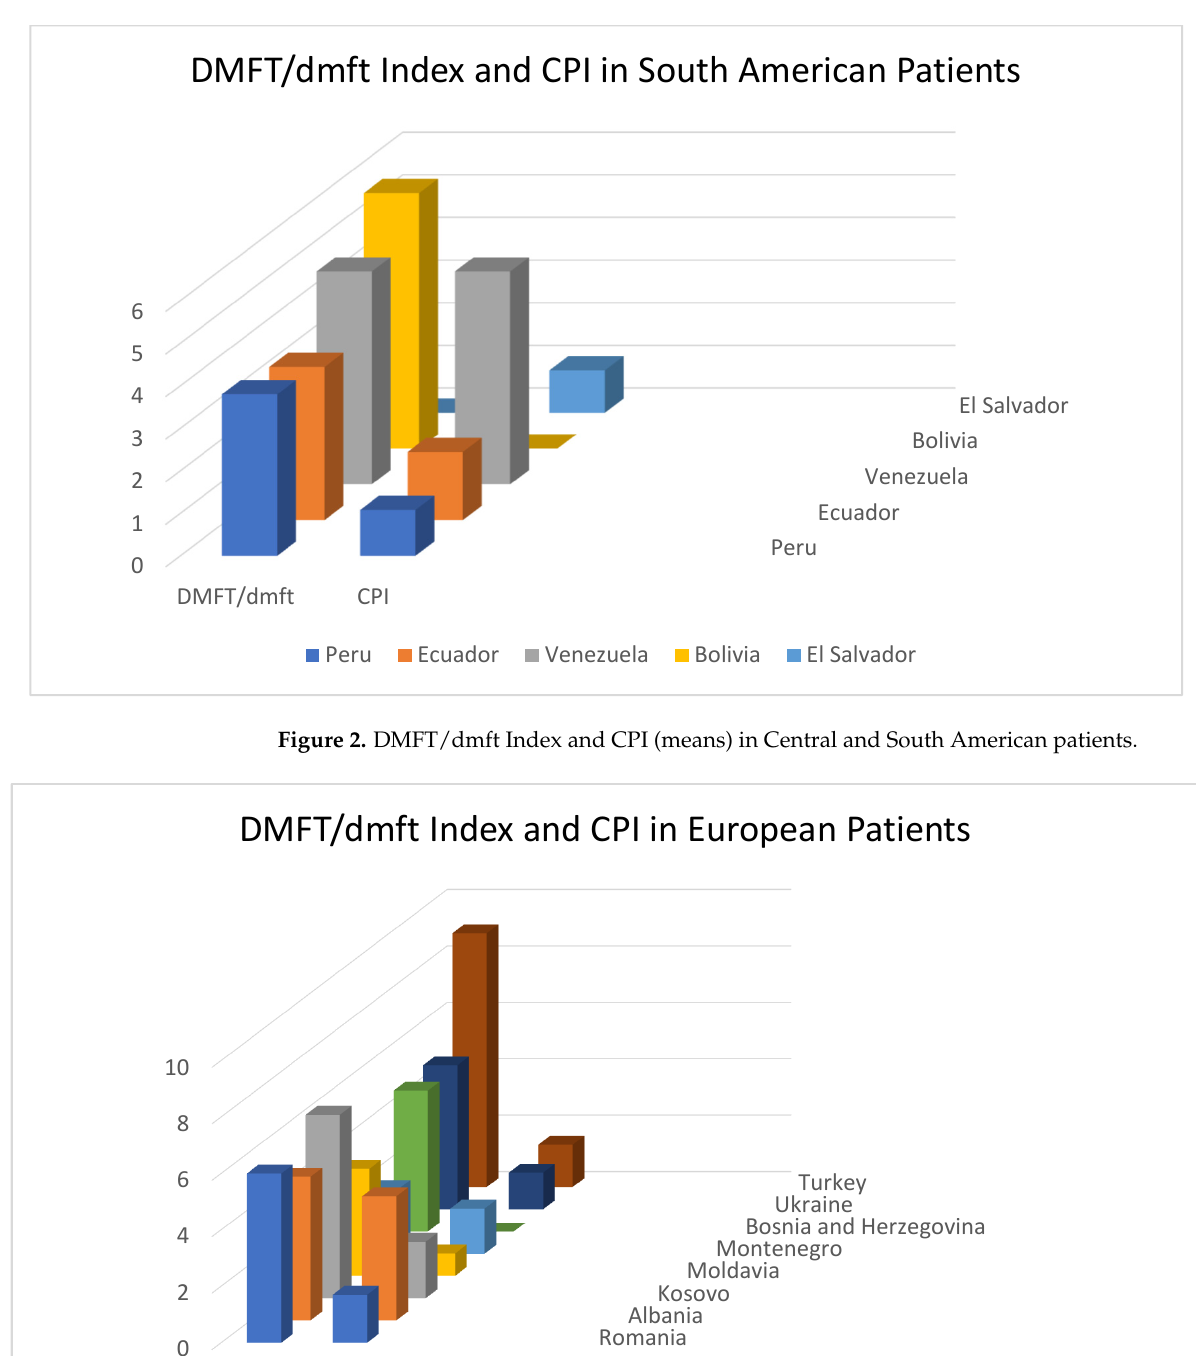
Figure 1. DMFT/dmft Index and CPI (means) in African patients.